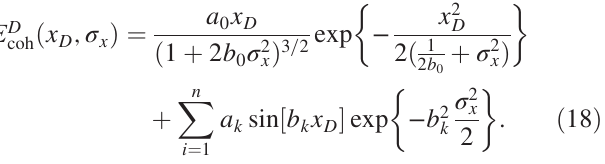
FIG. 8. Calculated COTR based beam profile images using the field approximations (a) Eq. (11) and (b) Eq. (14) for two different lens apertures. The dimensionless beam size amounts to σ 0 . 1 , the remaining parameters are the same as before. x ¼